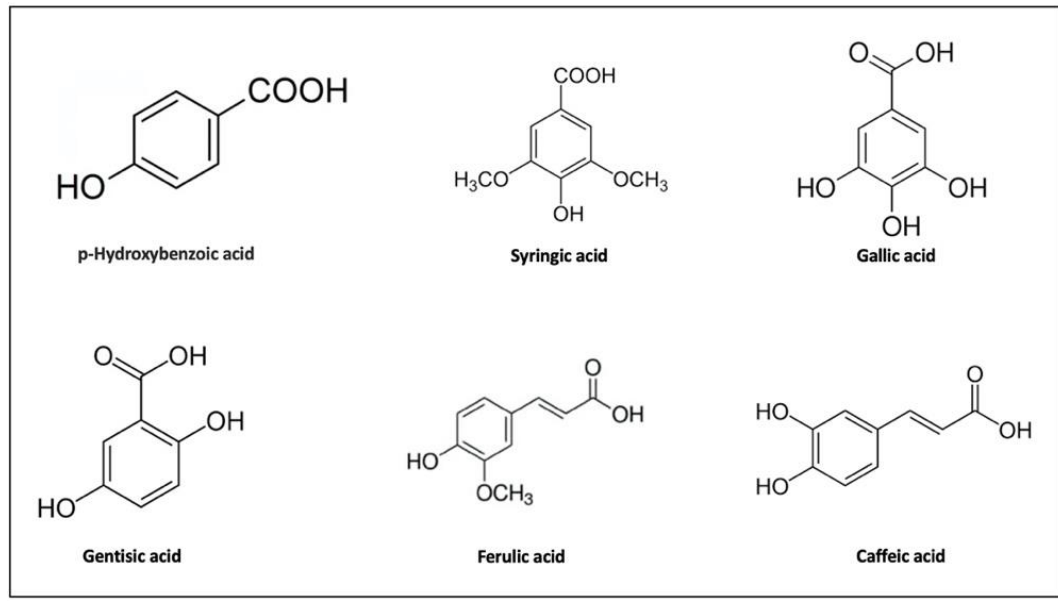
Posidonia oceanica